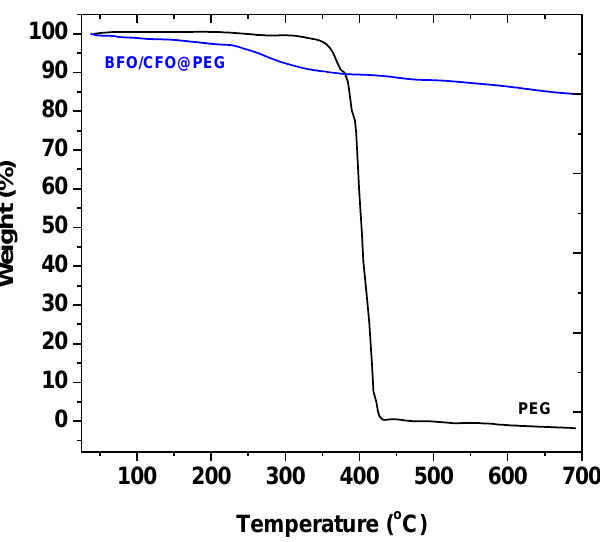
Figure 7. Thermal analysis of PEG and BFO/CFO@PEG.